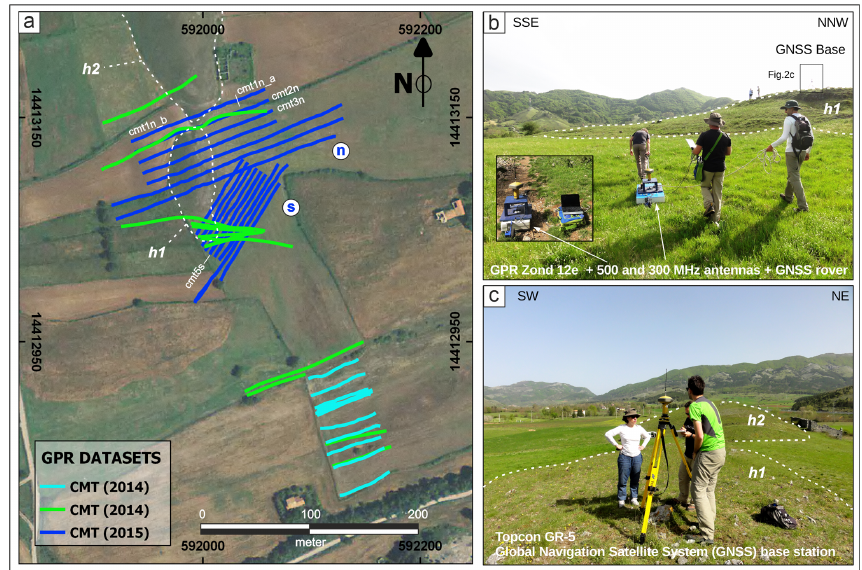
Figure 2. GPR acquisition campaigns: (a) GPR profiles collected at the study site Campotenese (“cmt”, where “n” and “s” stand for north and south, “h1” and “h2” indicate the two dolostone hills outcropping in the basin) during the three field visits (aerial image source: Regione Calabria – http://geoportale.regione.calabria.it/opendata, last access: 11 June 2021, under license IODL 2.0. – https://www.dati.gov.it/iodl/2. 0/, last access: 11 June 2021); (b) acquisition phase using the 300 and 500MHz antennae (in the insert) and GNSS receivers used for accurate data positioning; (c) GNSS base station set up during the fieldwork.